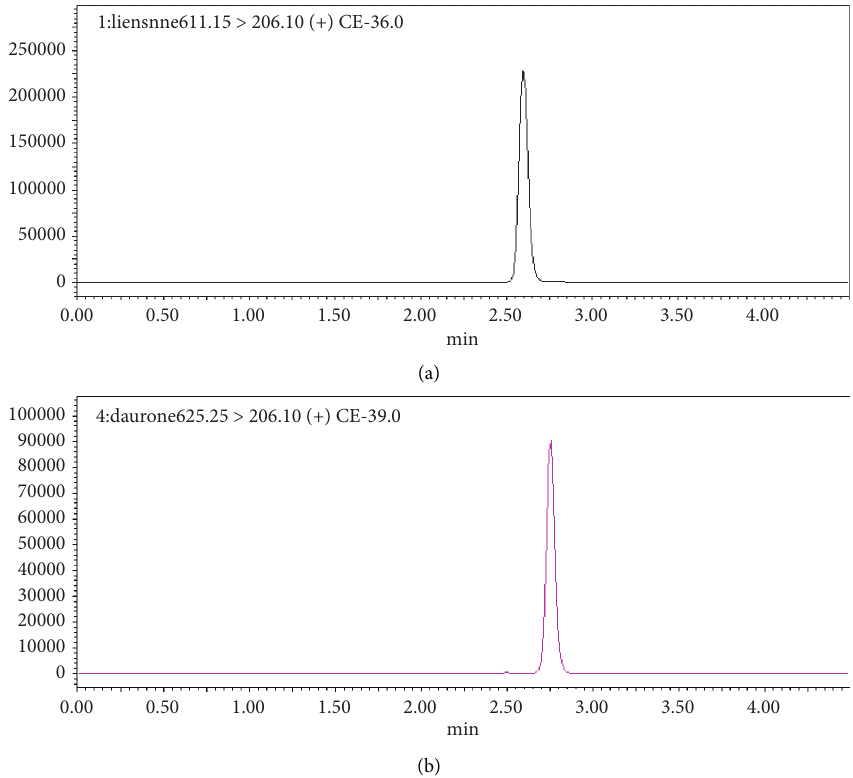
Figure 4: Chromatogram of (a) liensinine 10ng/mL, retention time 2.58min; (b) dauricine (IS) 20 ng/mL, retention time 2.75min, on Gemini-C18 column at high pH conditions (10mM NH4HCO3 buffer pH 10). Table 1: Liensinine and dauricine (IS) recoveries following extraction from rat plasma with three different solvents ( n � 3). Extraction